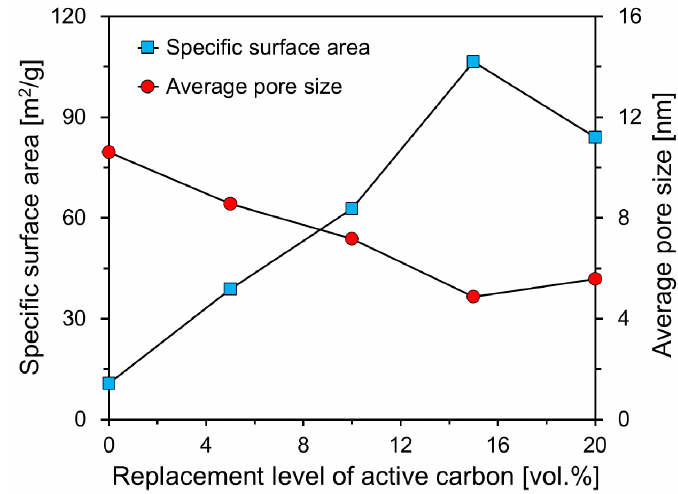
Figure 9. Specific surface areas and average pore sizes of foam composites according to replacement level of active carbon.